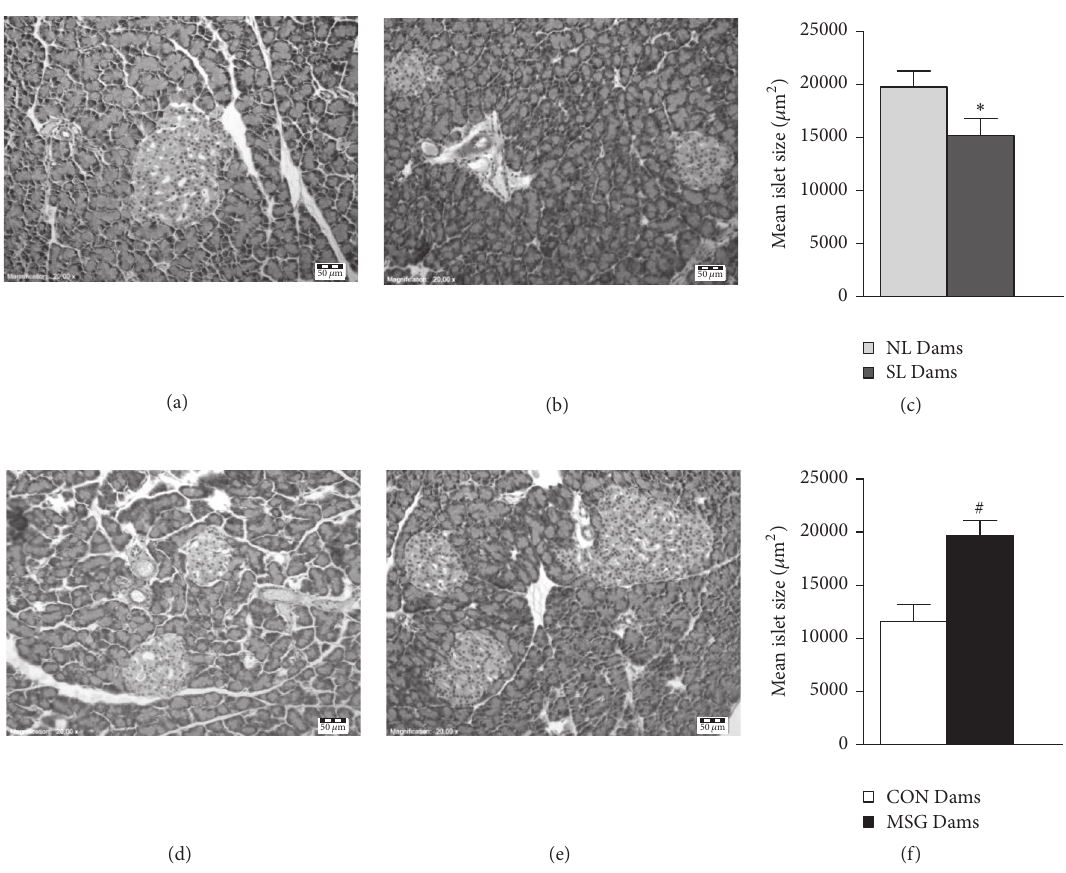
Figure 5: Adaptations in pancreatic islet histology in lactating dams at 21 days of lactation. Representative photomicrographs (magnification 200x; scale bar, 50 𝜇 m) of H&E-stained sections of pancreatic islets from lactating dams (a, b, d, and e). (c, f) Quantification of islet size ( 𝜇 m 2 ); data are median ± SEM. Sections were evaluated from 𝑛 = 3 dams/group and three image fields per section. Symbols above the bars represent statistical differences according to Student’s t -test ( 𝑝 < 0.05 ). ∗ NL Dams versus SL Dams; # CON Dams versus MSG